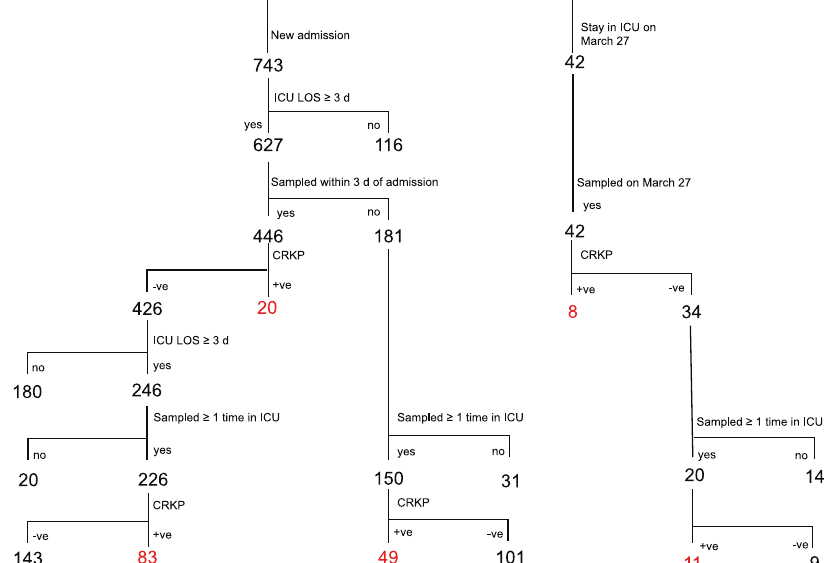
Fig. 1 Schematic of patients swabbed in the study and those leading to isolation of CRKP. Patients staying within the ICU for more than 72 h were screened for CRKP using rectal swabs; where possible, swabs were collected within 72 h of their admission. For those patients who were CRKP negative on screening, and continued to stay for at least 7 days, we collected additional swabs to test for nosocomial acquisition. Patients sampled within 72 h of their admission showed a low colonization rate of just 4.5%. However, samples collected after 72 h, or indeed after patients had been within the ICU for some time, showed a much higher prevalence of CRKP (32.7 – 36.7%), indicating that CRKP is largely acquired within the ICU environment. Blue = patient cohorts, orange = sample collection, purple = CRKP negative, green = CRKP